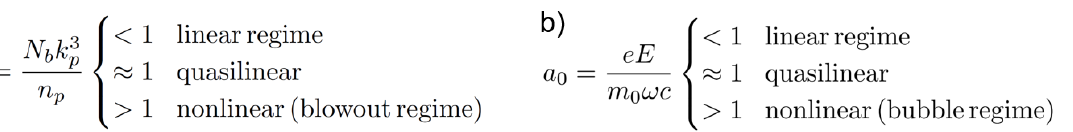
Figure 2. Linear, quasi-linear and non-linear regimes of PWFA ( a ) and LWFA ( b ), as indicated by the corresponding interaction value of ˜ Q and a 0 , respectively.